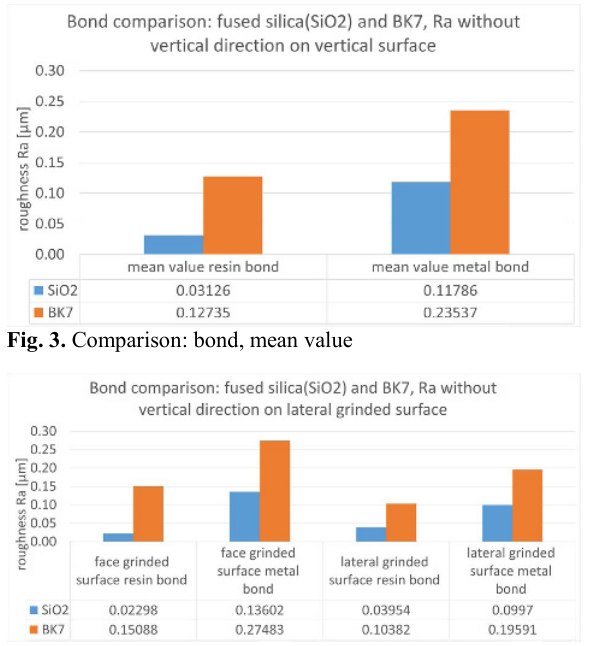
Fig. 4. Comparison: bond, face/lateral grinded surface